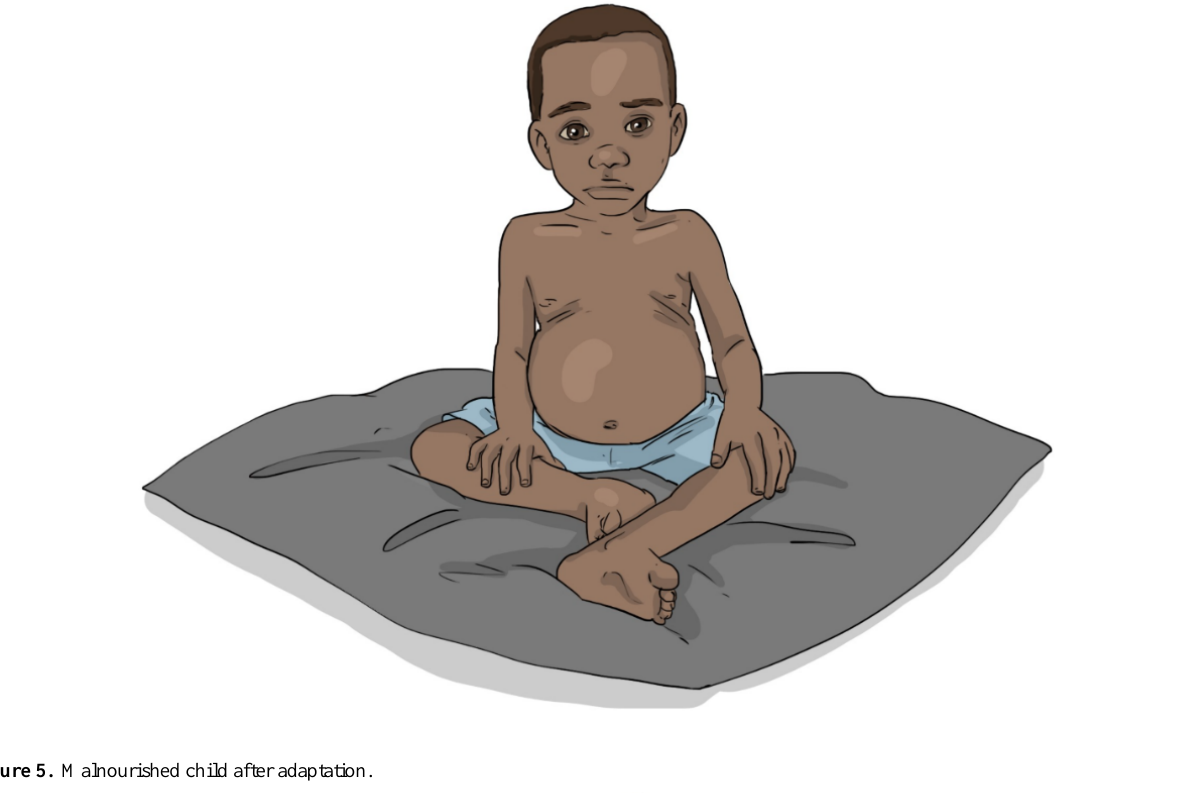
Figure 4. Malnourished child before adaptation.